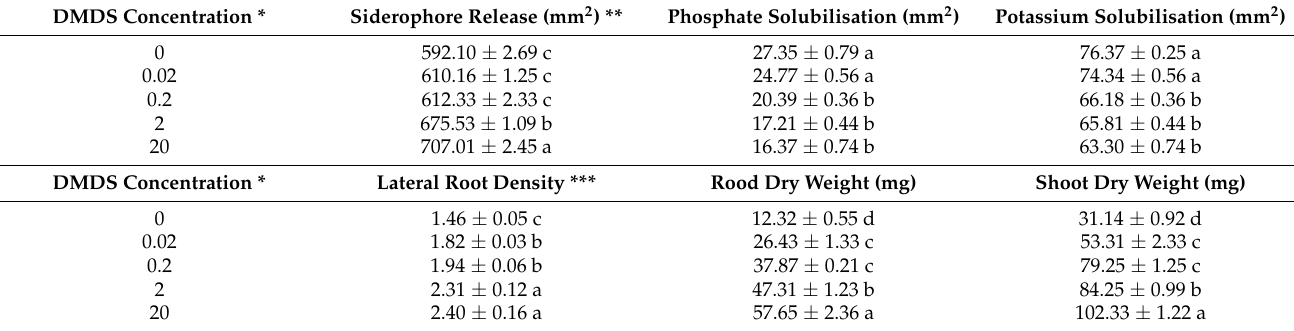
Table 2. Effect of pure dimethyl disulfide (DMDS) on the plant growth-promoting activities of Pseudomonas ( Ps. ) putida MVC 17 and tomato plant growth.